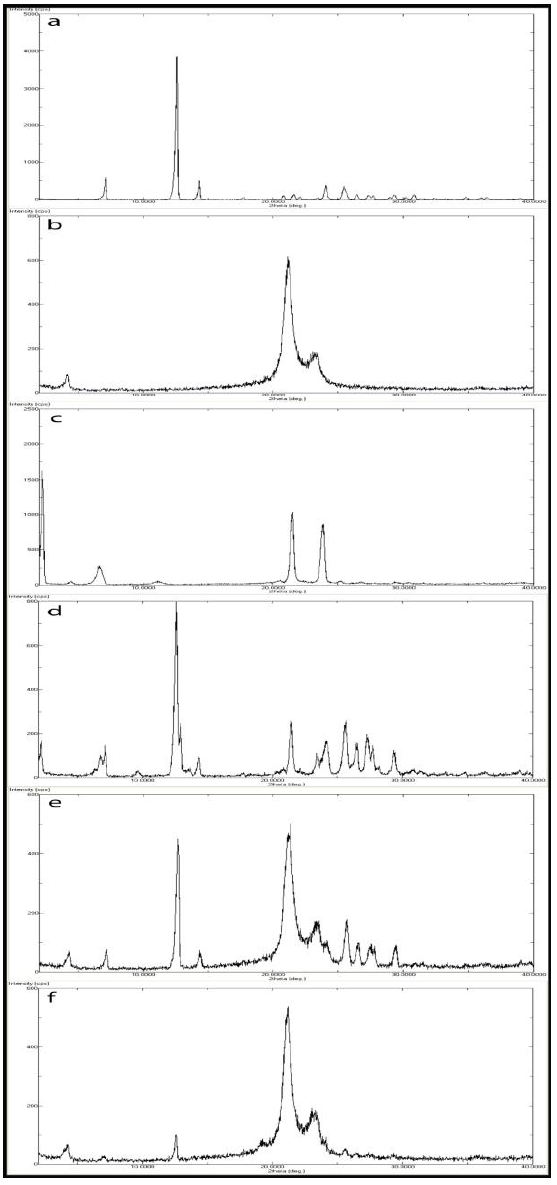
Figure 14: Powder X – ray diffraction Spectra of TP (a), GB (b), SA (c), TP – NPs (d), TP – GB physical mixture (e) and F O